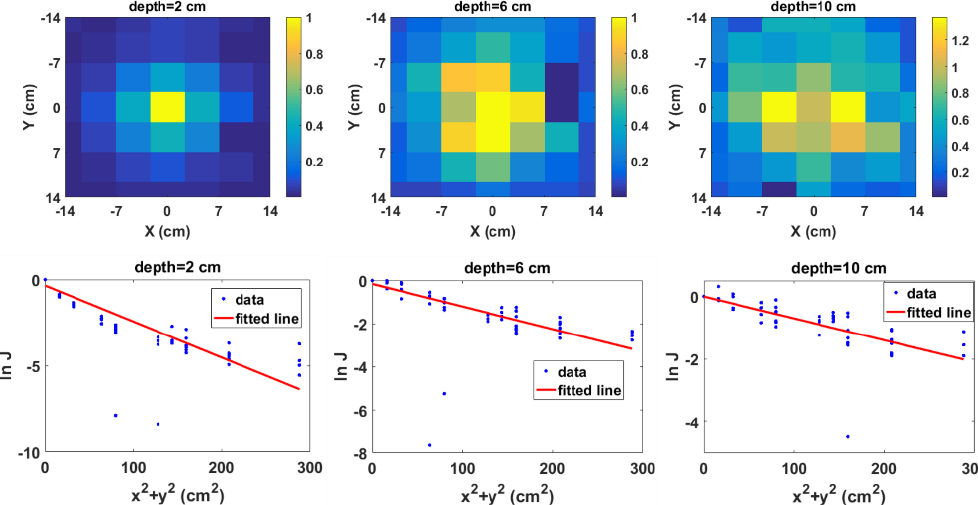
Figure 12. Normalised 2D radiation image using photons from the Compton peak region ( top row ) and corresponding model plot ( bottom row ) for selected depths from the